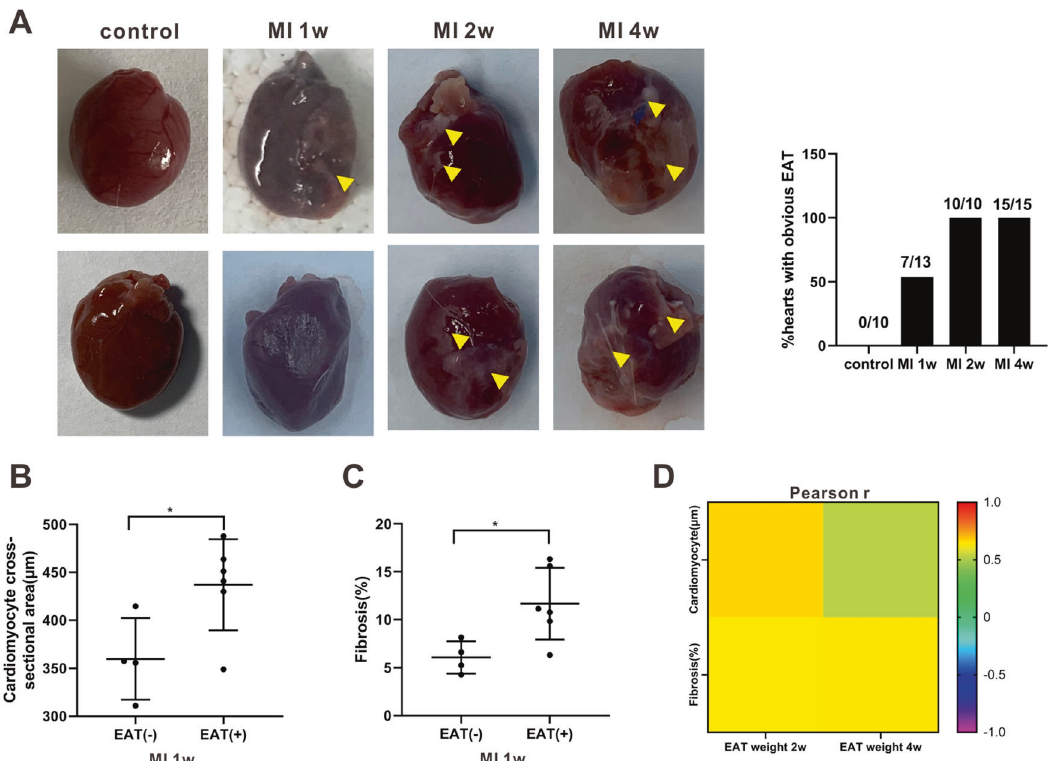
Fig. 2 The correlation between epicardial adipose tissue (EAT) and adverse myocardial remodeling. A Left: Representative images of hearts of rats in the control, MI 1-week, MI 2-week, and MI 4-week groups. Triangles: obvious EAT. Right: The ratio of hearts with obvious EAT in each group. The ( B ) cardiomyocyte cross-sectional areas and ( C ) myocardial fi brosis areas in the rats with ( + ) or without ( − ) EAT in MI 1-week group. * P < 0.05. D Pearson ’ s correlation coef fi cient ( r ) of EAT weights and cardiomyocyte size/myocardial fi brosis areas in rats in the MI 2-week and MI 4-week